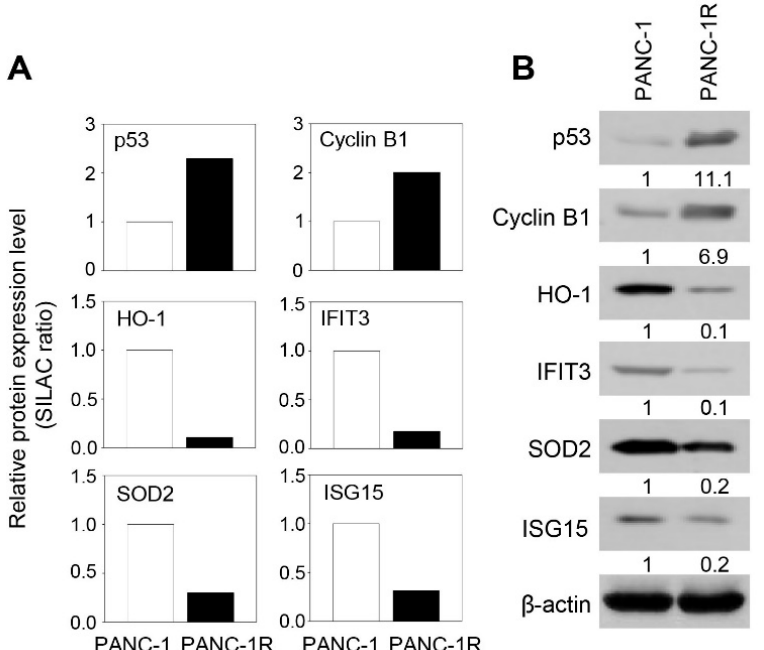
Figure 5. Validation of SILAC data by Western blot analysis. ( A ) Relative protein expression level of selected proteins (p53, cyclin B1, HO-1, IFIT3, SOD2, and ISG15) from SILAC data. Protein expression levels were normalized to oxaliplatin sensitive PANC-1 cells. ( B ) Validation of selected proteins (p53, cyclin B1, HO-1, IFIT3, SOD2, and ISG15) in both oxaliplatin sensitive and resistant PANC-1 cells by Western blot. β -actin was used as a loading control. Full-length Western blot images are presented in Supplementary Figure S2.